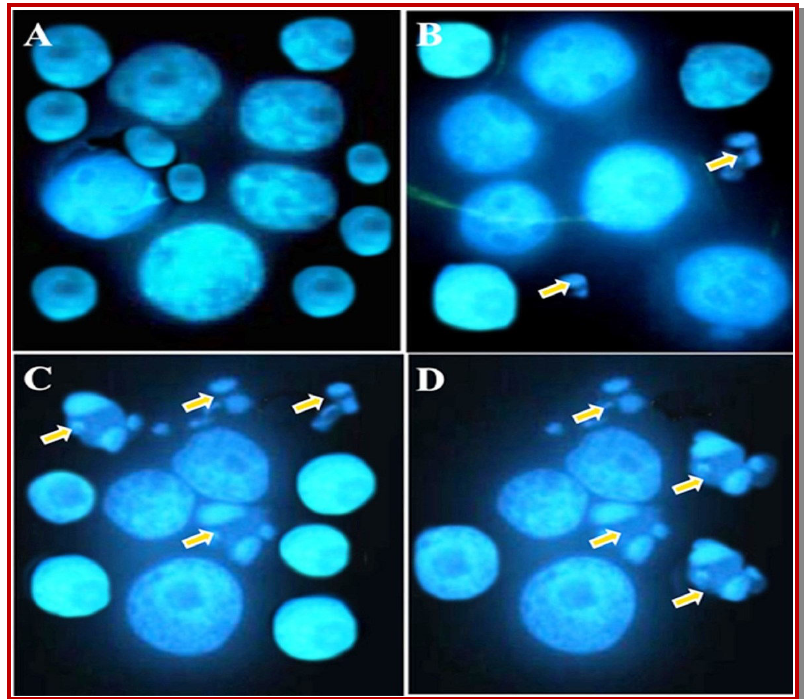
Figure 4: Fluorescence microscopic images of Hep-G2 cancer cells after treatment with 0 (A), 10 (B), 50 (C) and 100 (D) µM eri- odictyol for 48 hours. The cells were stained with DAPI. Untreated cells (A) showed normal morphology while as treated